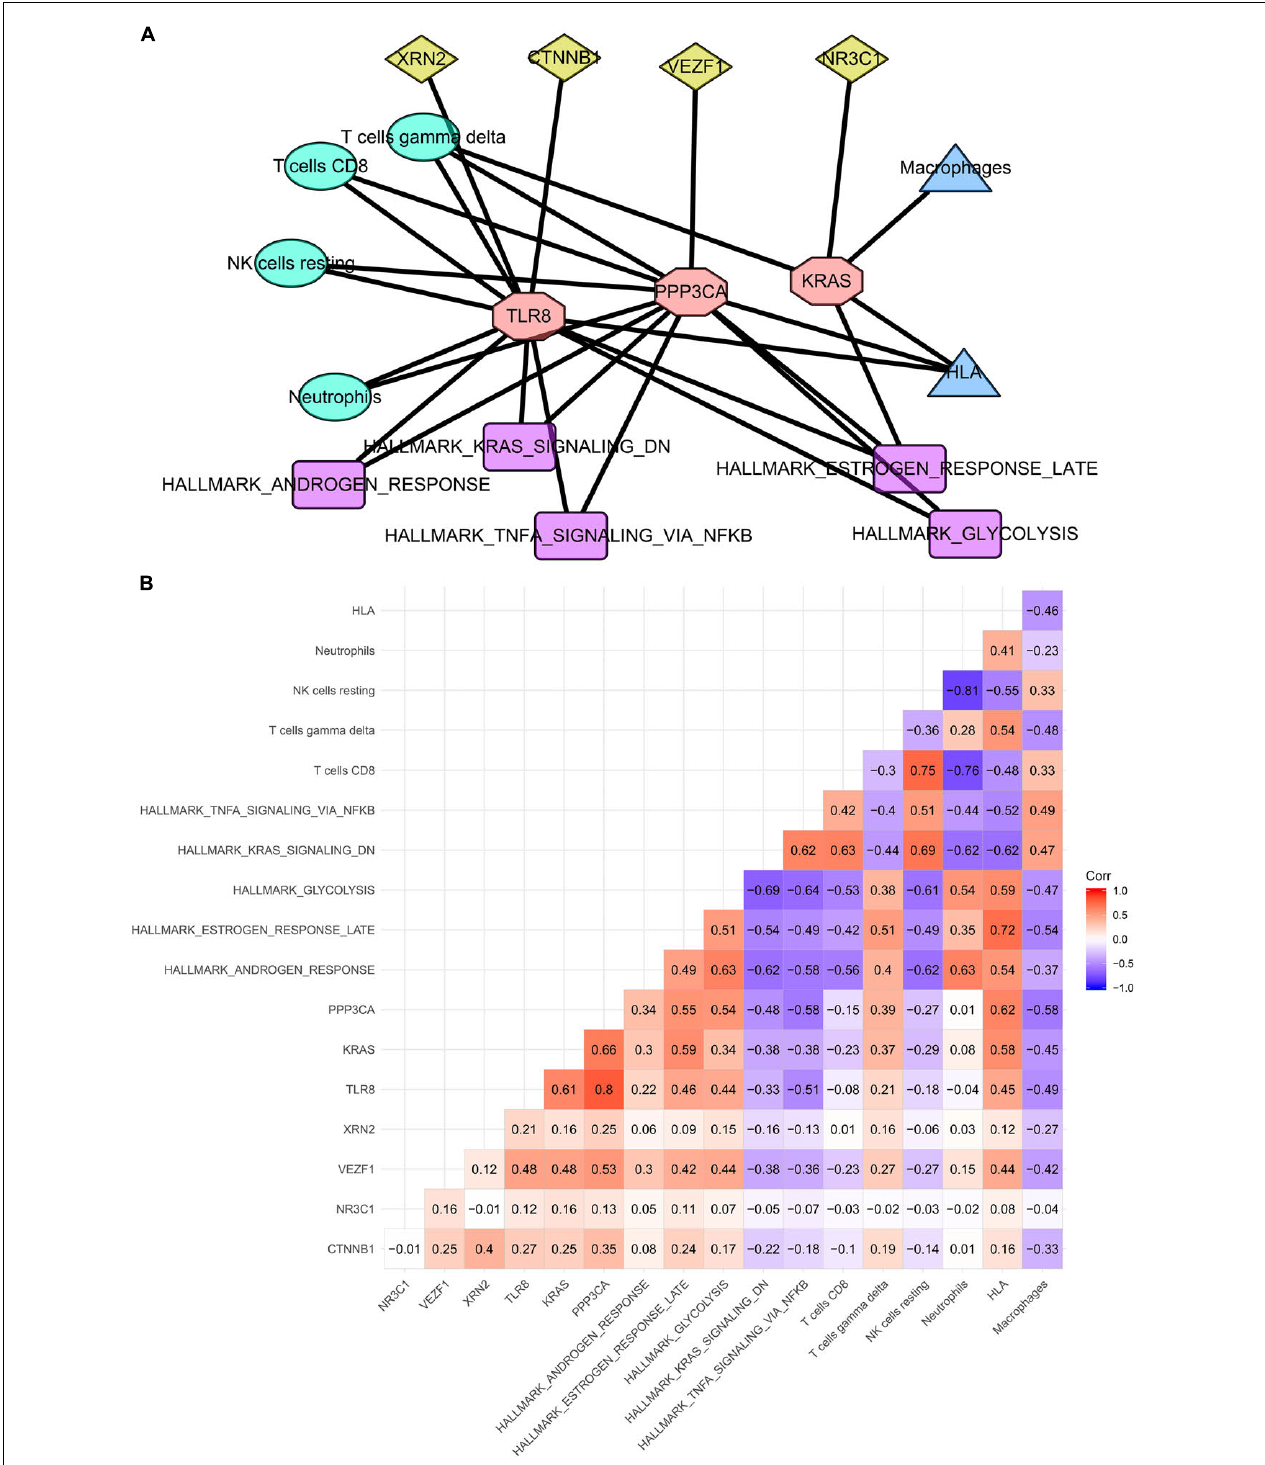
FIGURE 5 | Construction of regulation network among key SSSIRGs and their upstream TFs and the downstream pathways/immune cells/immune gene sets in septic shock. (A) Overview of the protein–protein interaction network. Three SSSIRGs (TLR8, PPP3CA, and KRAS) were screened by the co-expression analysis with 28 co-expression interaction pairs including four TF-SSSIRG interaction pairs, nine SSSIRG-immune-cell interaction pairs, four SSSIRG-immune-gene-set interaction pairs, and 11 SSSIRG-pathway interaction pairs used for construction of the regulation network. (B) Co-expression heat map illuminating all co-expression patterns of SSSIRGs with both upstream TFs and the downstream signaling pathways/immune cells/immune gene sets.